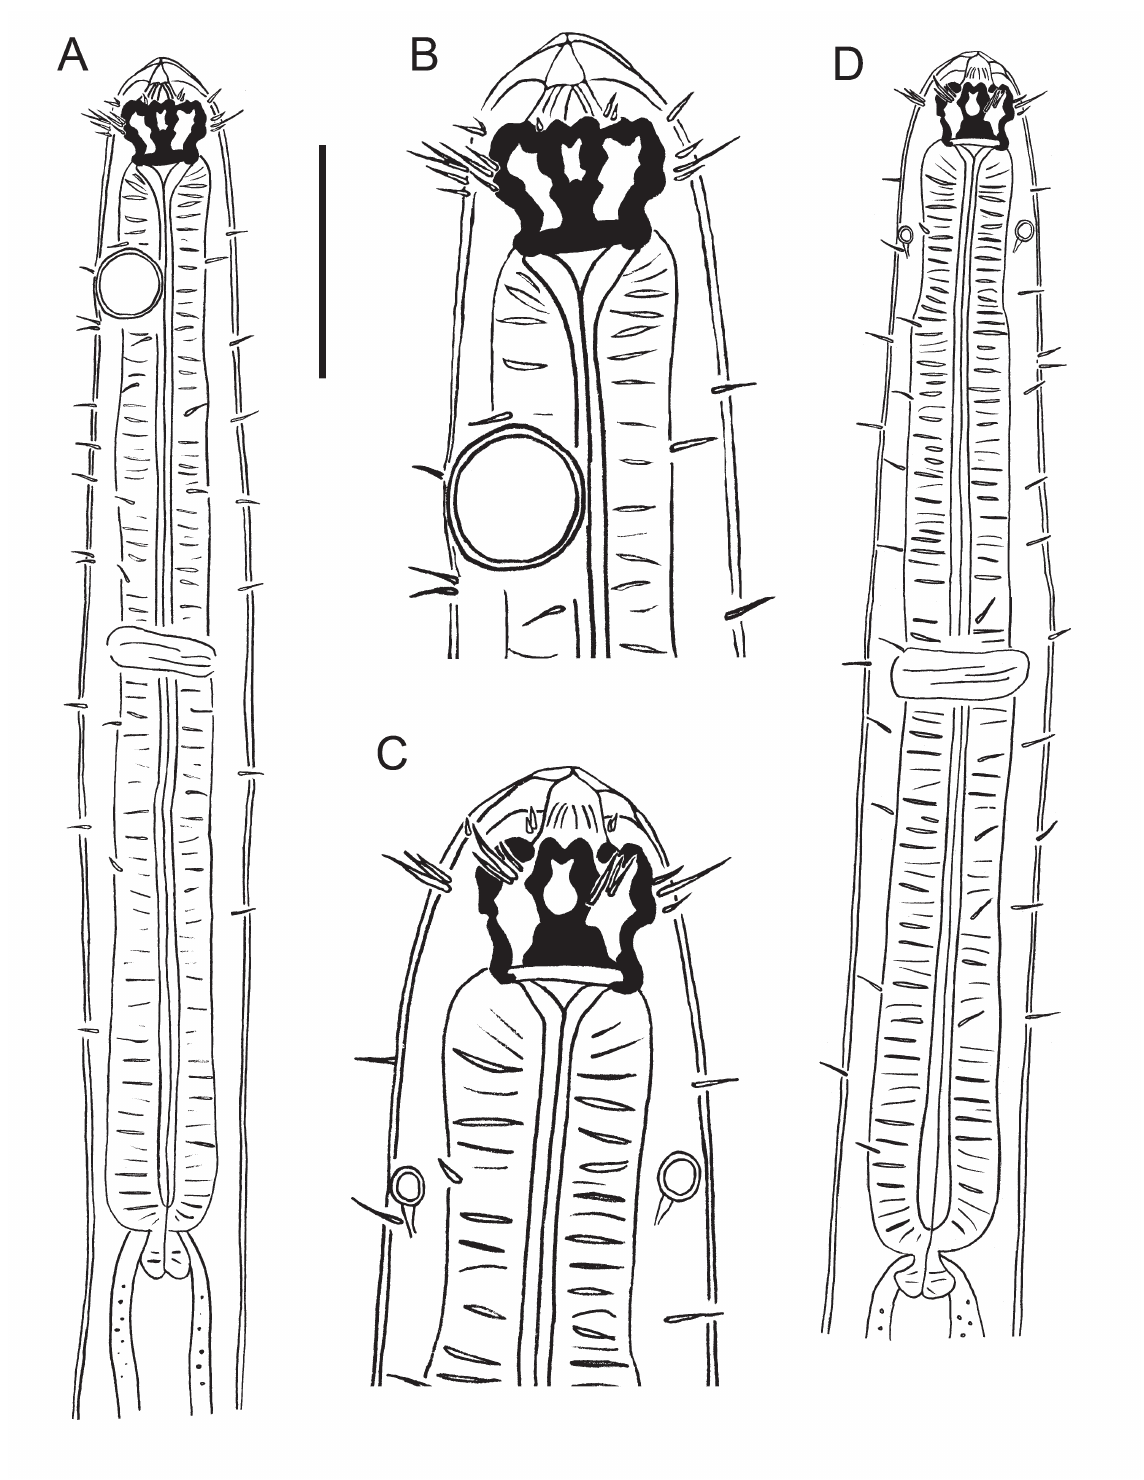
Fig. 4. Metasphaerolaimus constrictus sp. nov. A . Holotype, ♂, anterior body region. B . Holotype, ♂, head. C . Female head. D . Female anterior body region. Scale bar: A = 50 µm; B–c = 25 µm; D = 55